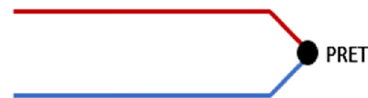
Figure 2: Pret as a liminal entity at the intersection of the two